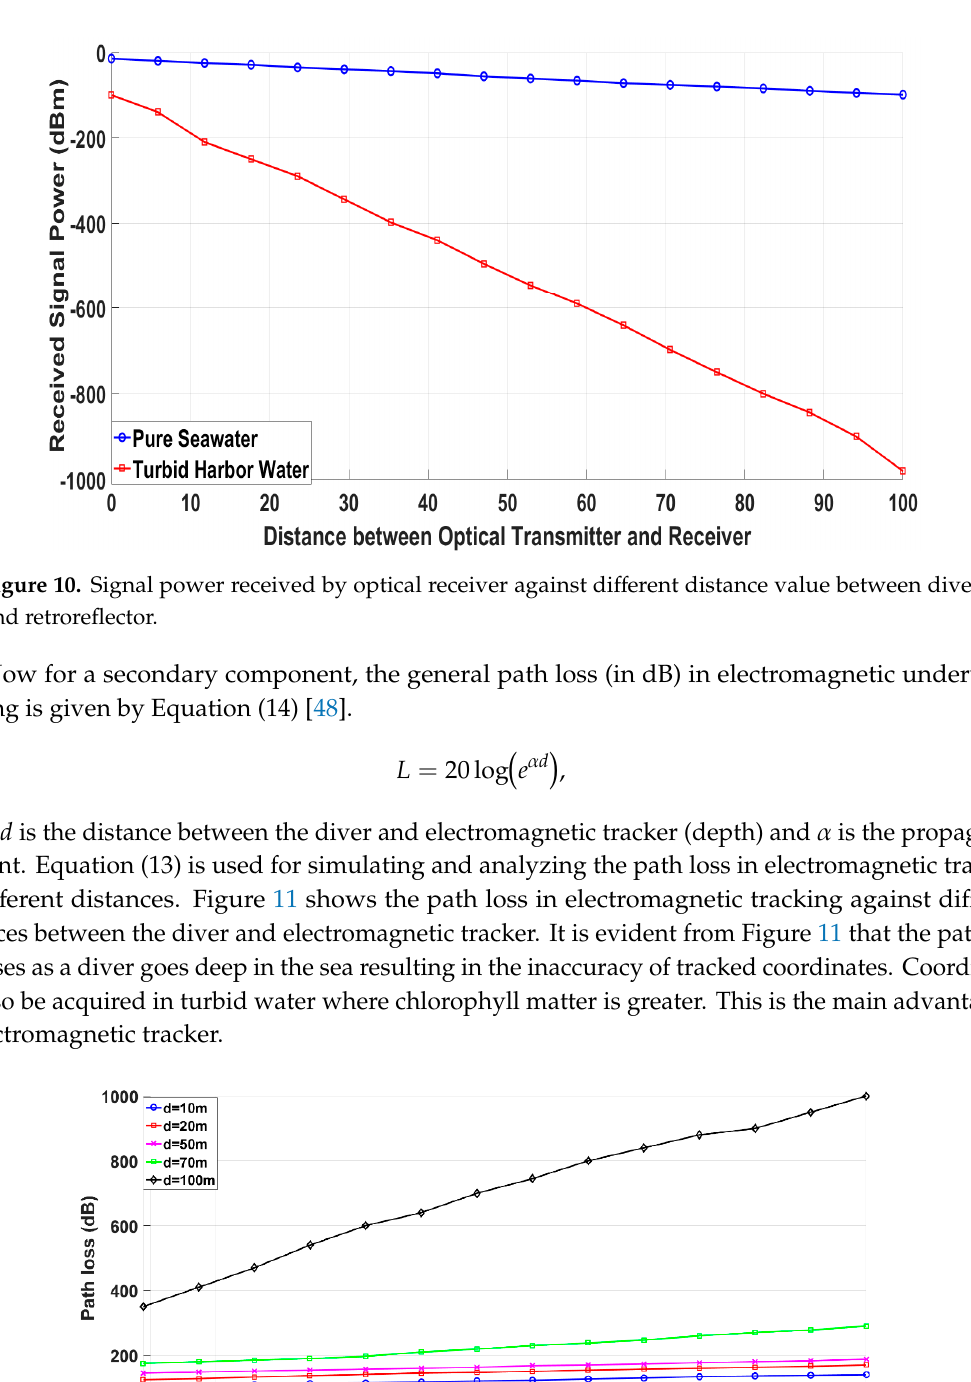
Figure 12. Flowchart of working of hybrid underwater diver tracking system. The accuracy of an electromagnetic tracker is high up to 15–20 m, but after exceeding the depth of 20 m the accuracy of an electromagnetic tracker declines. The proposed flowchart is intended to initiate with electromagnetic tracking if the diver depth is less than 15 m. If the diver depth increases and the chlorophyll content is under the permissible level then an increase in path loss will switch the tracking to optical mode. Similarly, if chlorophyll content increases, then the decrease in received power signal will switch the tracking to optical mode. The purpose of the hybrid version is to increase the tracking accuracy of the 3-DoF axis (X, Y, and Z) of the objects underwater. Figure 13 shows the possible hybrid model of optical and electromagnetic tracking-based wireless communication in the sea.